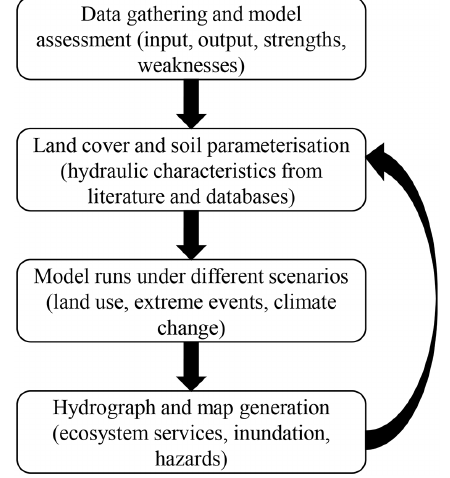
Figure 2. Methodology of the